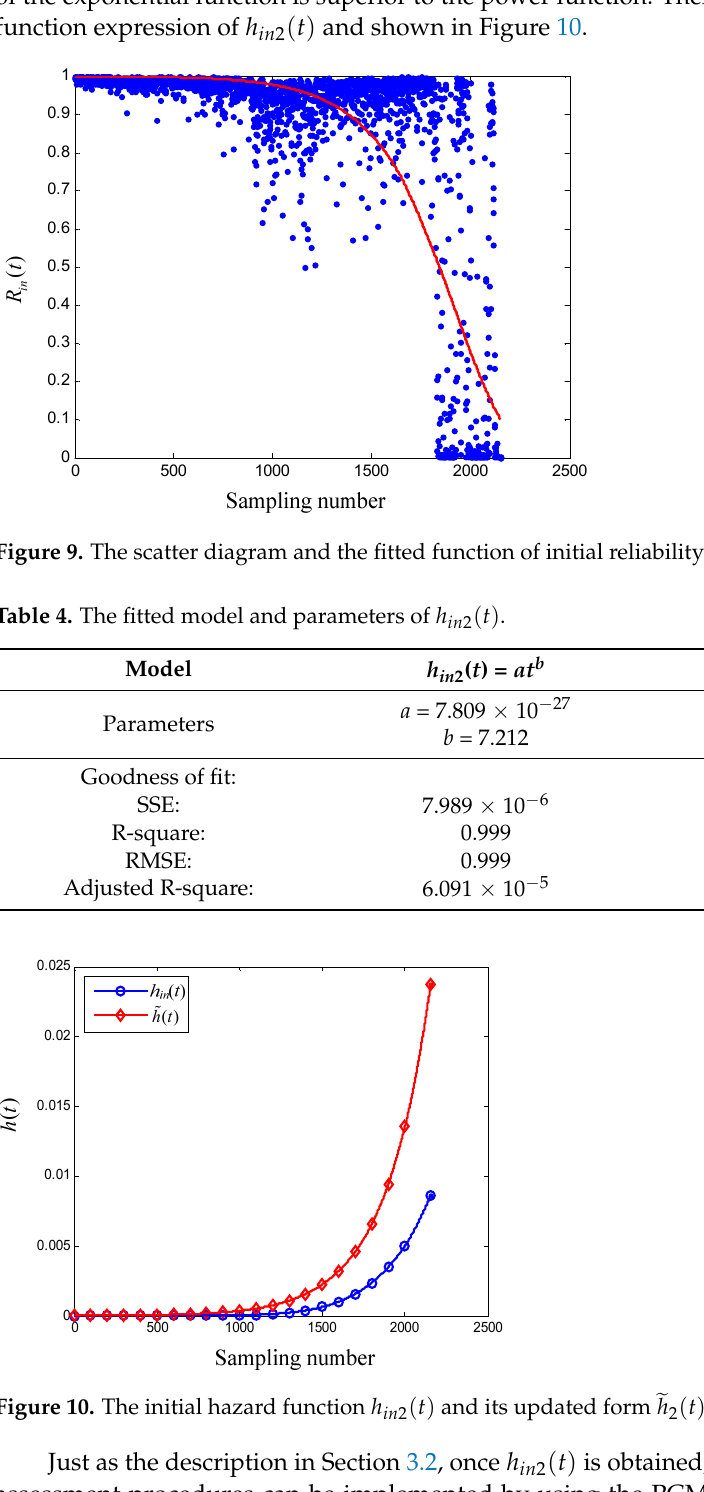
. Figure 11. The discrete form C k 2 and the continuous function form C 2 ( t ) of baseline covariate func- tion. The response covariates